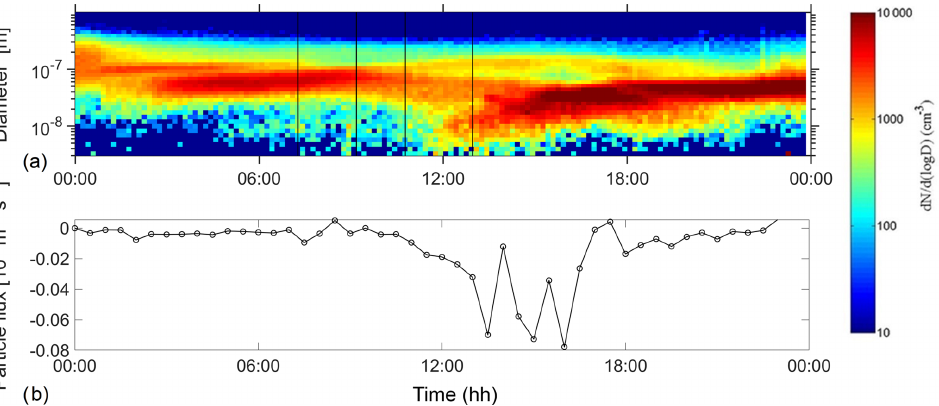
Figure 5. New particle formation event at SMEAR II in Hyytiälä on 13 August 2015. Panel (a) shows the number size distribution measured by a differential mobility particle sizer at ground level inside the forest canopy. Start and end times of two measurement flights are marked by vertical lines in figure. Panel (b) shows the particle flux measured at 23ma.g.l. at the station. Negative particle flux indicates particle flux downwards.